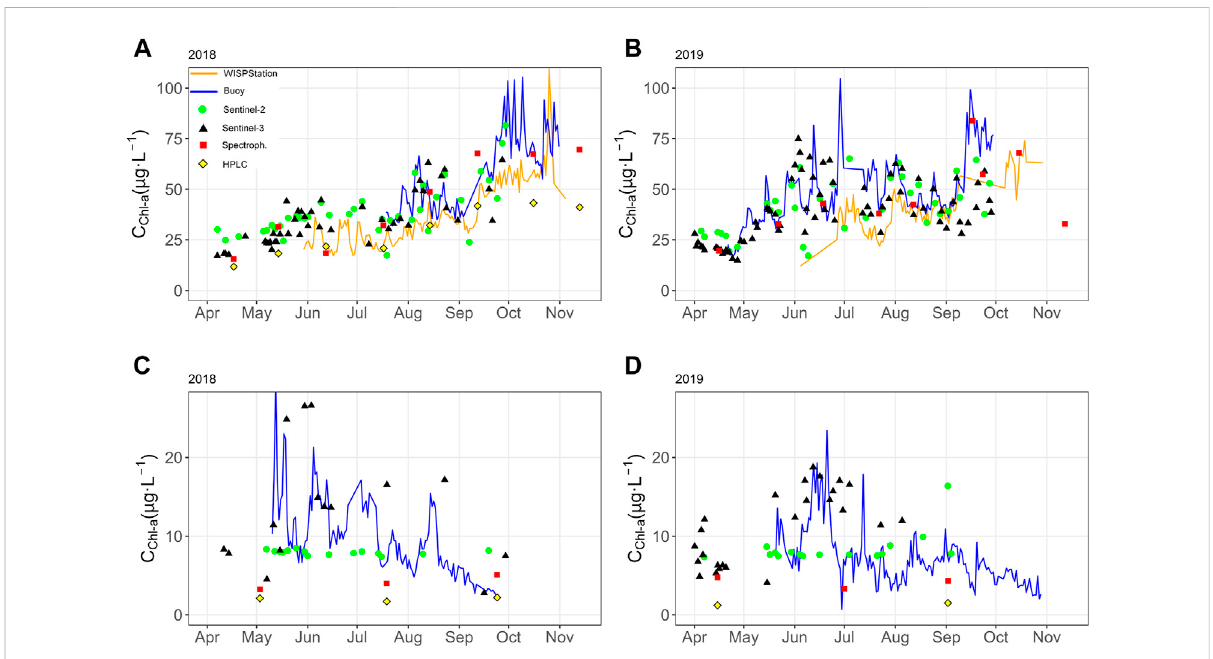
FIGURE 2 Midday C Chl-a time-series during vegetation period of 2018 and 2019, derived from various sensors in Võrtsjärv (A,B) : AHFM buoy, WISPStation, HPLC, spectrophotometric, S3, S2; and in Saadjärv (C,D) : AHFM buoy at Z 90 depth, HPLC, spectrophotometric, S3, S2. Note the different y-scale in fi